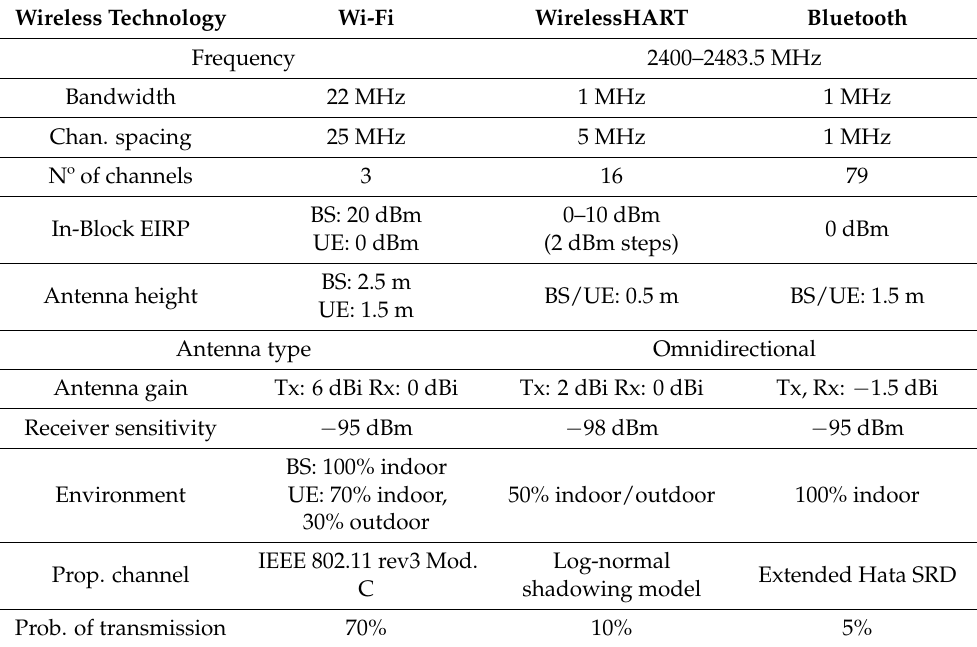
Table 1. Technical specifications of wireless systems (Wi-Fi, WirelessHART, and Bluetooth).